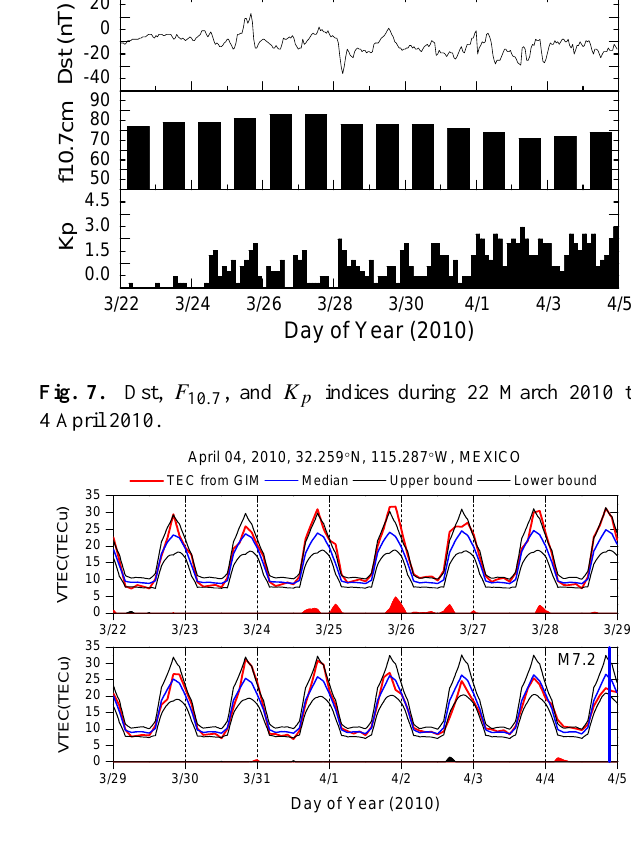
Fig. 8. VTEC time series above the Mexico epicenter during 22 March 2010 to 4 April 2010. Symbols in this figure are the same as those in Fig. 3. The number of times of each grid point occurring anoma- lies from 04:00 LT to 18:00 LT on 11 August 2010 was counted (Fig. 11). The grid points with anomalies were mainly distributed in the Southern Hemisphere. The grid points repeated less than 3 times had wider distributions, those repeated 5–6 times were mainly focused over the west of the epicenter, and those repeated 6 times were distributed in areas with > 50 ◦ longitude and > 20 ◦ latitude. The distri- bution of the ionospheric anomalies confirms the relationship between the anomaly and the earthquake. The hypocenter depth of this earthquake was 211 km, and obvious pre-earthquake ionospheric anomalies occurred. Therefore, the hypocenter depth cannot be the main factor